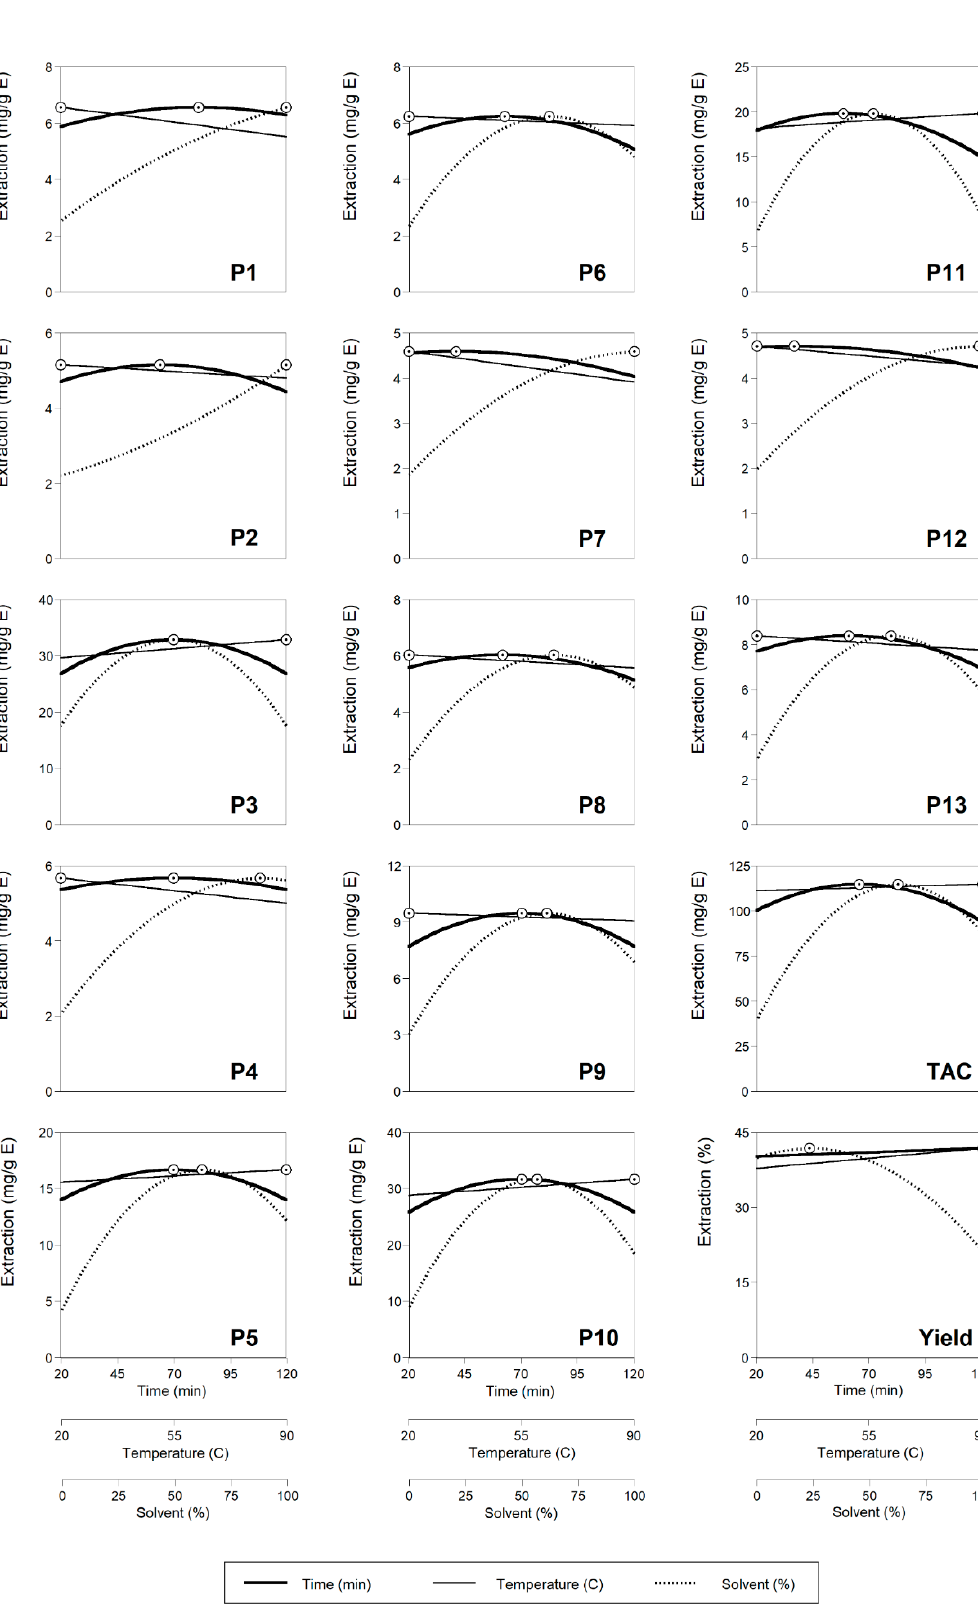
Figure 4. 2D graphical response of the effects of the independent variables on the extraction of anthocyanin compounds from red rubin basil leaves (see Figure 1 for peak identification). Dots ( (cid:12) ) represent the optimal values. In each plot, each independent variable was positioned at the optimal value of the other two variables (Table 3).